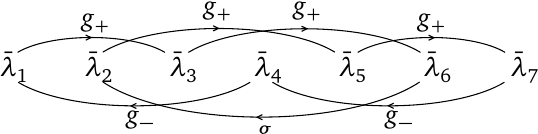
Figure 7: Cycle associated with the transformation in Eq.